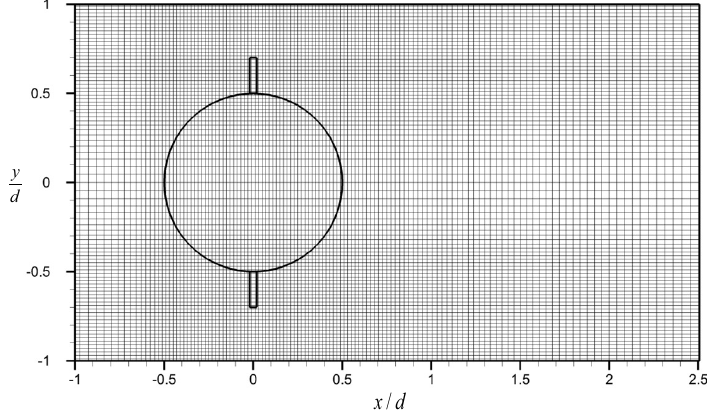
Figure 3. Grid distributions near a circular cylinder with tabs in the x – y plane. Every other grid is shown.